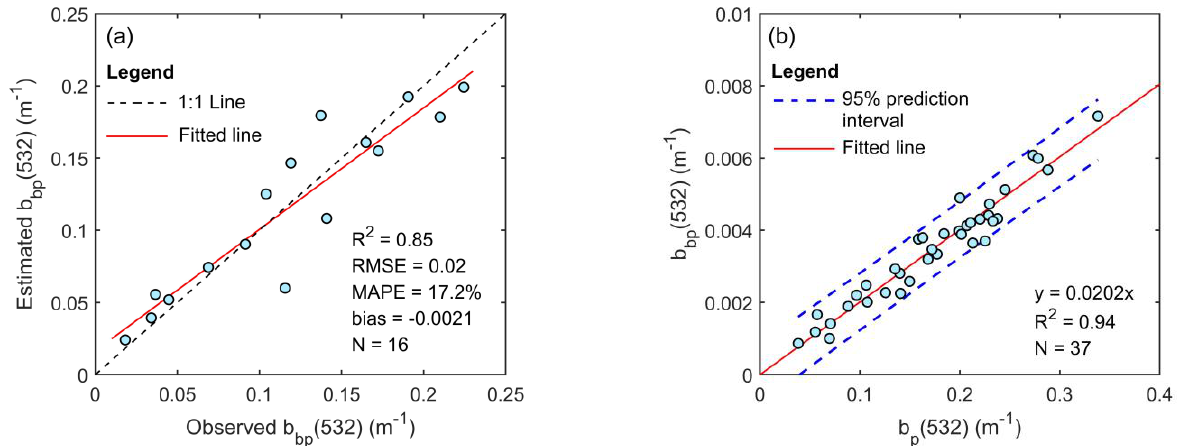
Figure 3. ( a ) Validation of QAA method for b bp (532) retrieval. ( b ) The relationship between b bp (532) and b p (532). As for V tot (D) retrieval, we compared the results of the empirical models calibrated by b p (532) and b bp (532). The V tot (D) retrieval model calibrated by b p (532) held a higher accuracy, with an R 2 of 0.75 (Figure 4a), and the V tot (D) retrieval model calibrated by b bp (532) showed a lower accuracy, with an R 2 of 0.72 (Figure 4b). Moreover, signal saturation appeared in two sites for the b bp (532) data, which indicates that b bp (532) might not be available in high-turbidity water. Hence, b p (532) was used to calculate V tot (D) in this study.